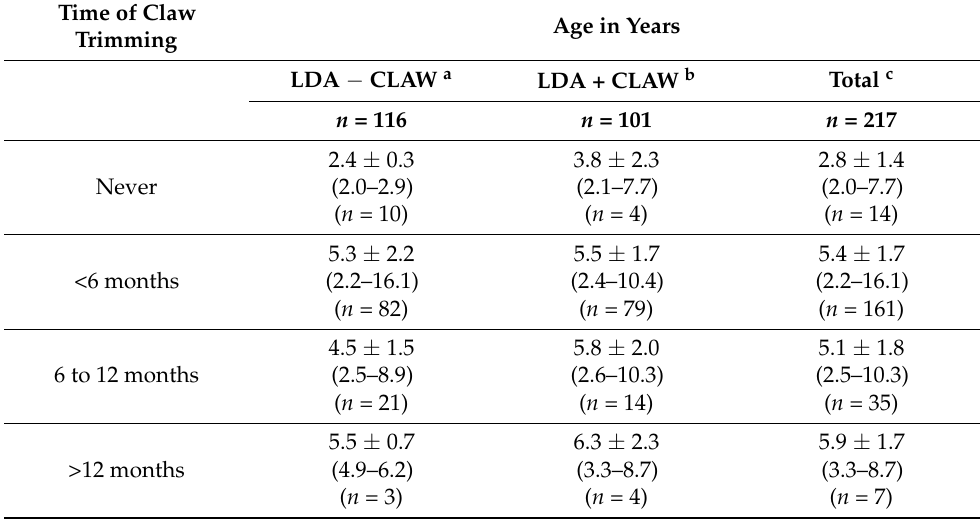
Table 4. Distribution of age (in years) and occurrence of claw trimming in cattle diagnosed with left displacement of the abomasum and no (LDA − CLAW) or at least one (LDA + CLAW) claw lesion. Data about time of last claw trimming was missing for a total number of 35 animals, 19 for LDA − CLAW and 16 for LD + CLAW.